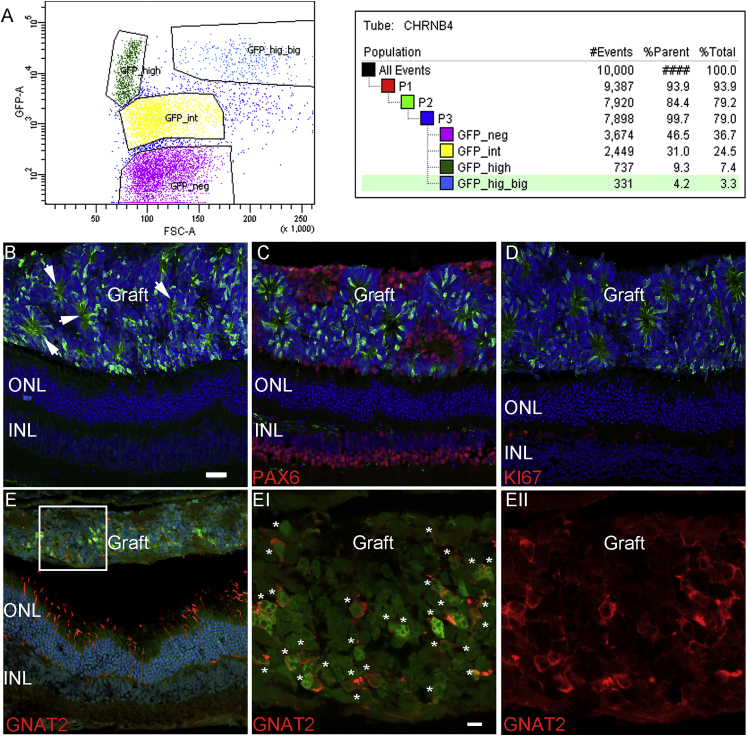
E12-Derived EGFP-Positive Cells Generate Cones after Transplantation into Adult NOD/SCID Retinas(A) Flow cytometry analysis of EGFP-positive cells from dissociated E12 mouse retinas. Different EGFP intensities and cell complexities were detected and gated in blue, green, and yellow, respectively. All EGFP-positive cells were injected. (B–E) Example is shown of rosette-like structures formed in the sub-retinal space of NOD/SCID mice, 4 weeks after grafting (white arrows in B). (C) PAX6-positive (in red) and EGFP-negative cells in the sub-retinal space of adult retinas are shown. (D) Transplanted cells resulted to be KI67 negative. (E–EII) Double GNAT2- EGFP-positive cone cells. (EI–II) High magnification of cell graft is shown (E, white square). DAPI, nuclear staining (blue); ONL and INL, outer and inner nuclear layer; n = 5. Scale bars, 30 μm (B–E) and 15 μm (EI–II).